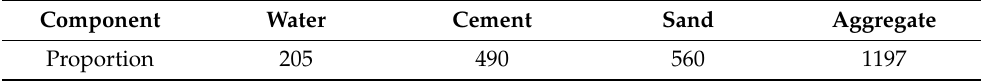
Table 3. Mix proportion of C50 concrete coupons (in units of kg/m 3 ).